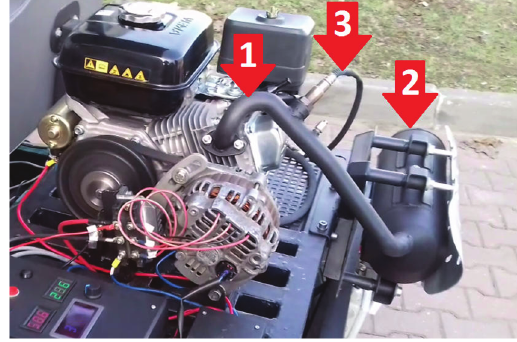
Fig. 8. An adapted exhaust system mounted to the range extender: 1 – exhaust pipe, 2 – muffler with TWC, 3 – wideband oxygen sensor